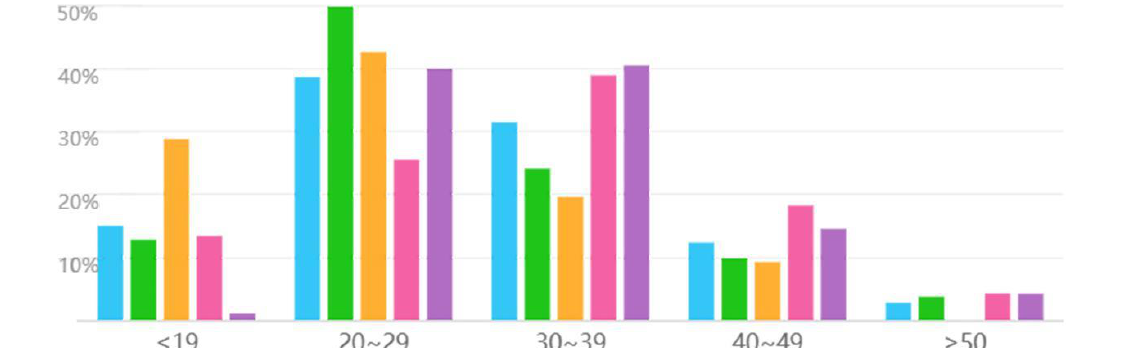
Figure 4. Baidu search age distribution of water-related vocabulary (In turn, they represent the age distribution proportions of searches for water resources, water resources protection, water pollution, water saving, and water resource fees and taxes).